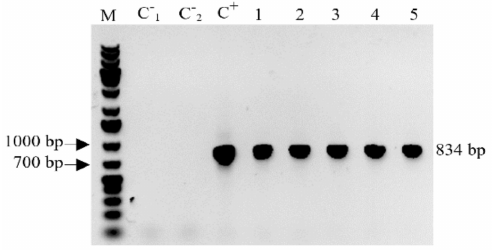
Figure 2. RT-PCR amplification of an 834 bp fragment from MBP::rhLL-37 gene transcript. M, 1 kb plus DNA ladder; C − 1 , negative control (RNA template); C − 2 , negative control (non-transformed plant); C + , positive control (gDNA of MBP::rhLL-37 transgenic barley plant); lane 1, T5 and lanes 2–5, T6 progenies of MBP::rhLL-37 transgenic barley